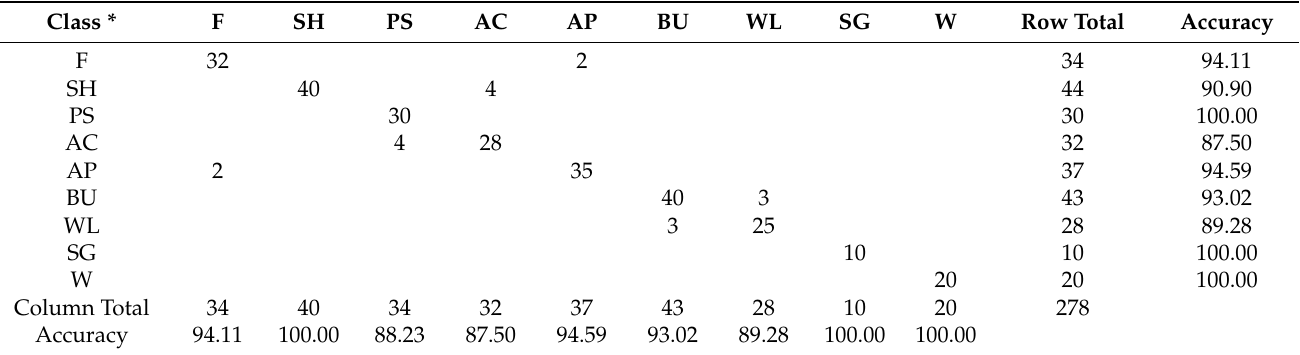
Table 2. Accuracy assessment of LULC